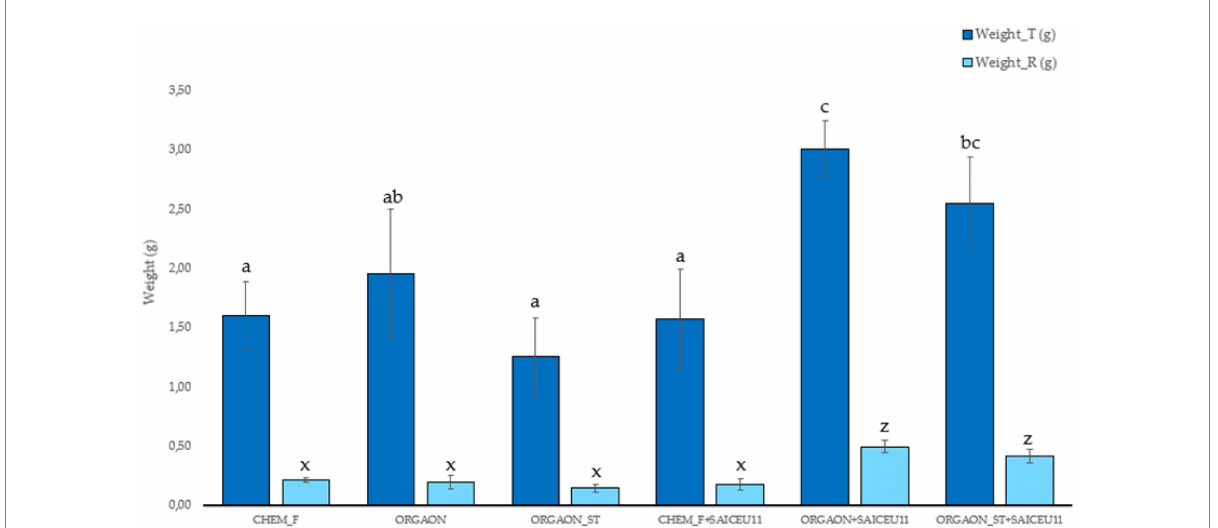
FIGURE 1 Weight biometrics of lupine plants subjected to different irrigation treatments with biofertilizer with SAICEU11 T . Different letters denote statistically significant differences according to Duncan test ( p < 0.05) for total plant weight (a, ab, and c) and root weight ( x and z